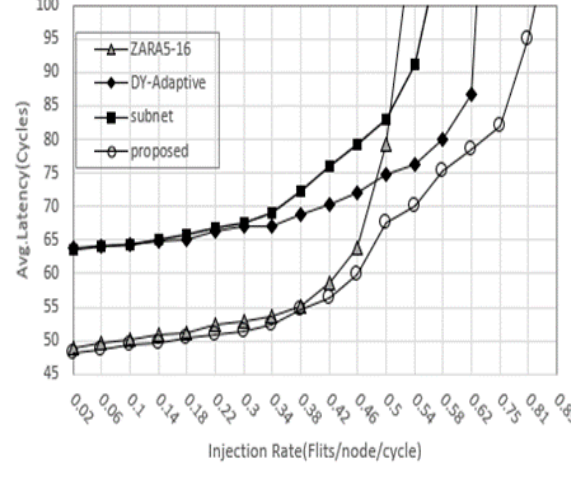
Fig. 10. Average latency evaluation under synthetic uniform random traffic pattern